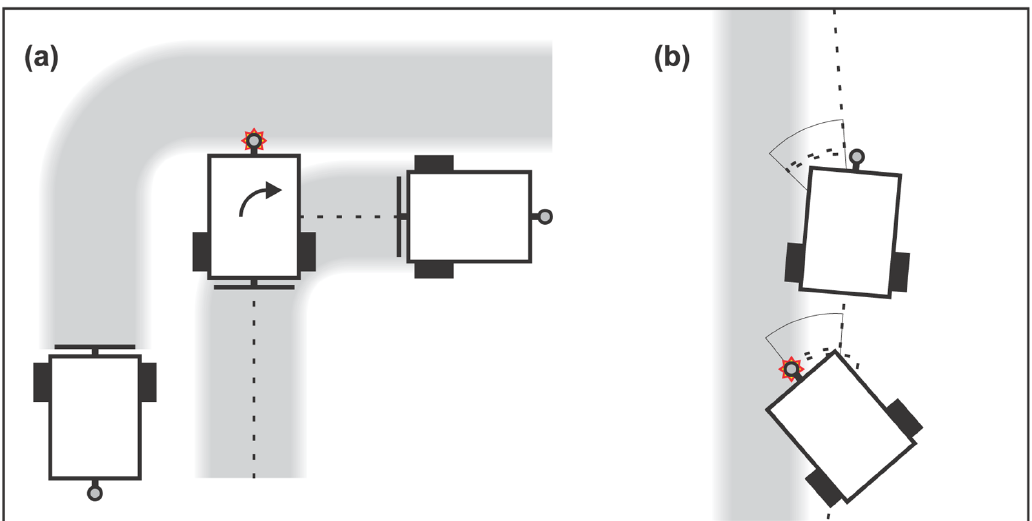
Figure 10 . Trail guidance strategies with a single gas sensor. (a) Repellent chemical marker. The example shows cleaning robots that use an odourous trail to indicate the area that has already been cleaned. (b) Trail following with a single gas sensor